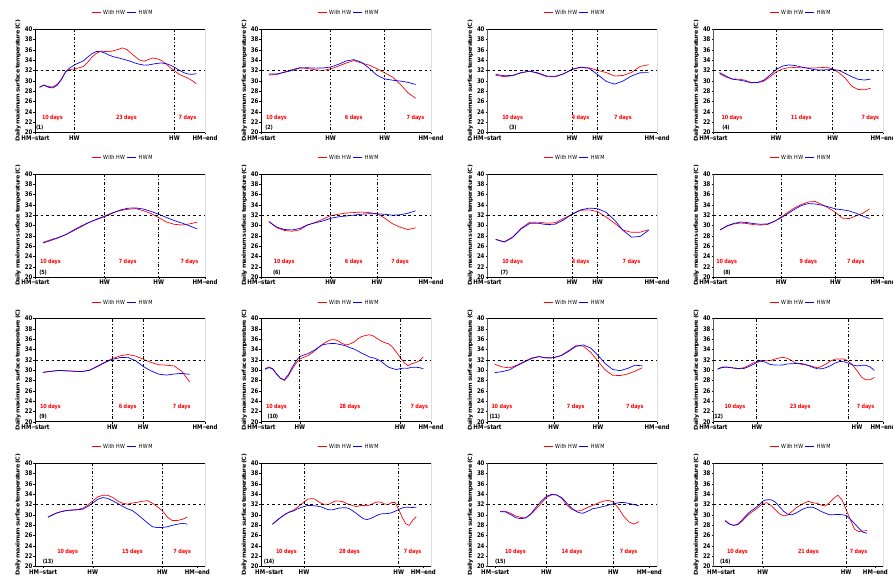
Figure A6. Time evaluations of the area-averaged daily maximum surface air temperature ( ◦ C) for the simulation with HW (red curve) and with HW suppression (blue